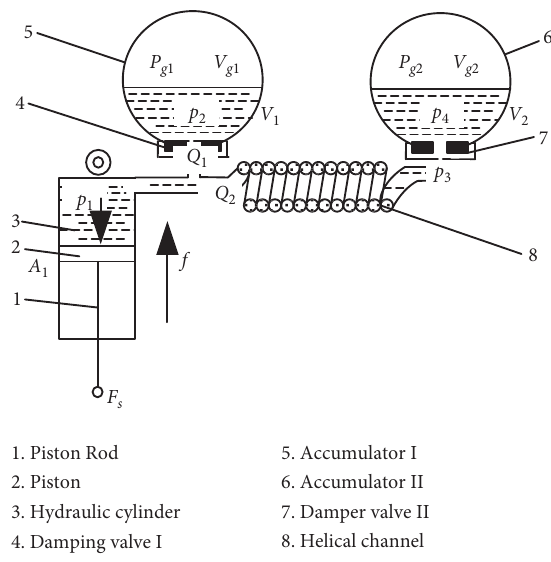
Figure 1: Schematic of hydro-pneumatic ISD